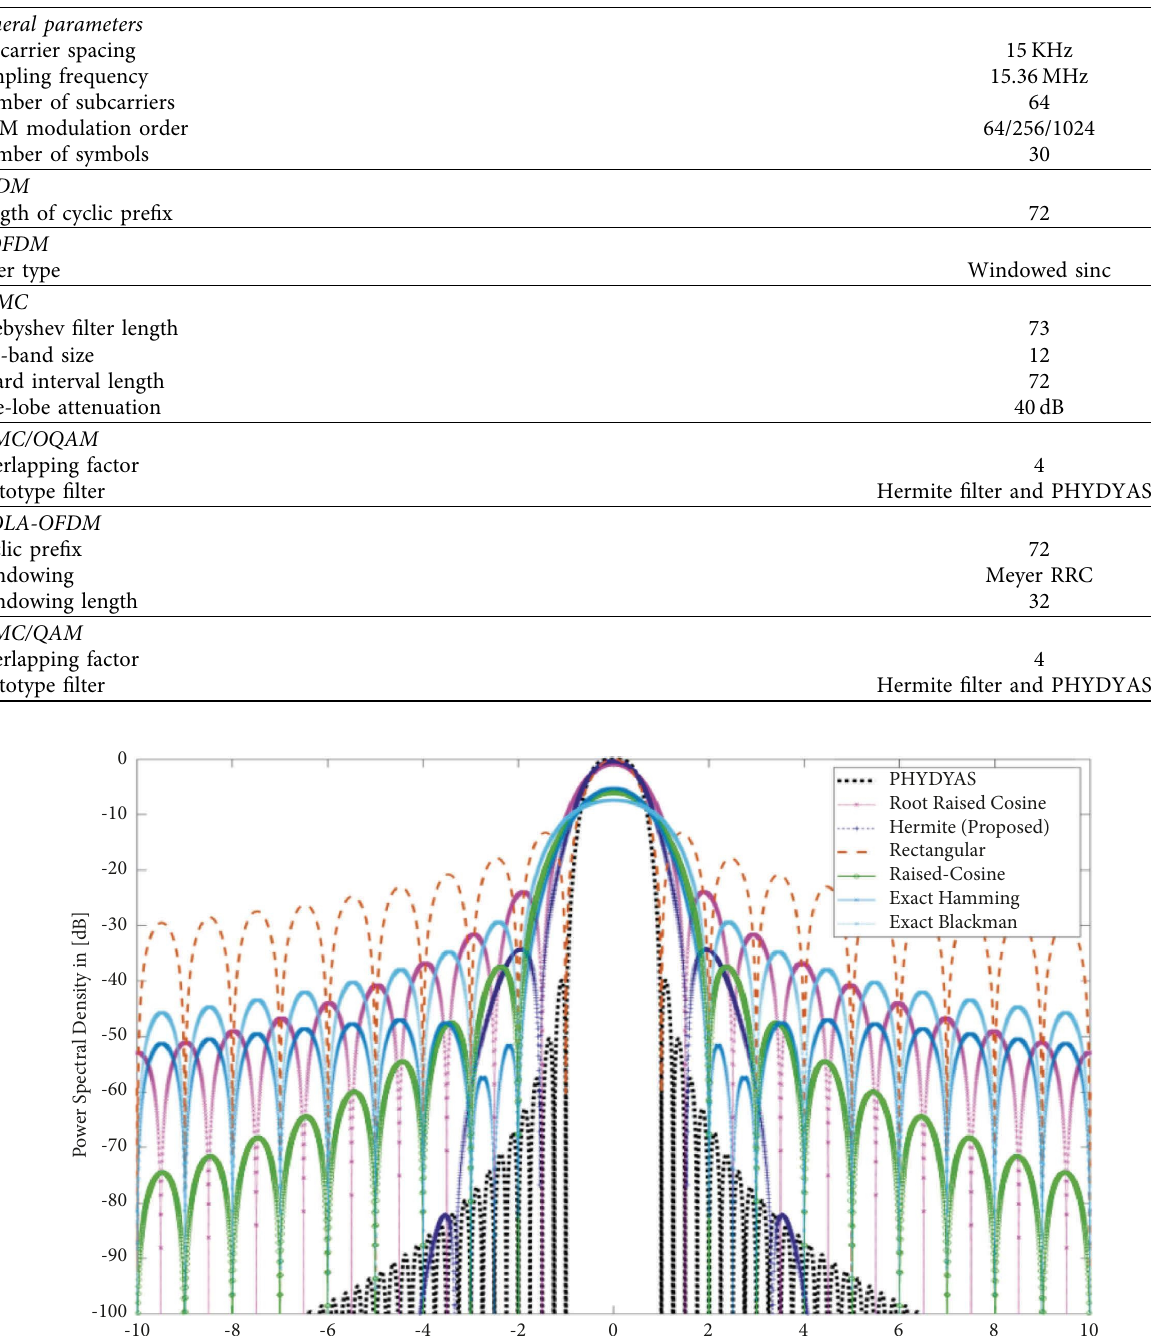
Table 1: Simulation parameters.